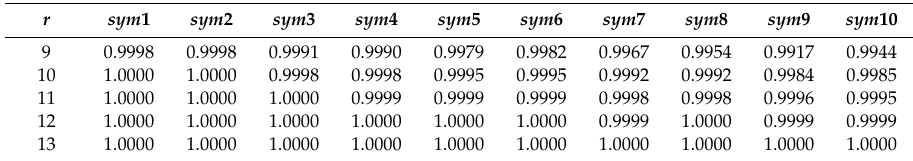
Table 20. Experimental results ( SSIM ) of 3D tomographic 8-bit image “wmri” DWT by using bit-width r of symlets filters coe ffi cients.